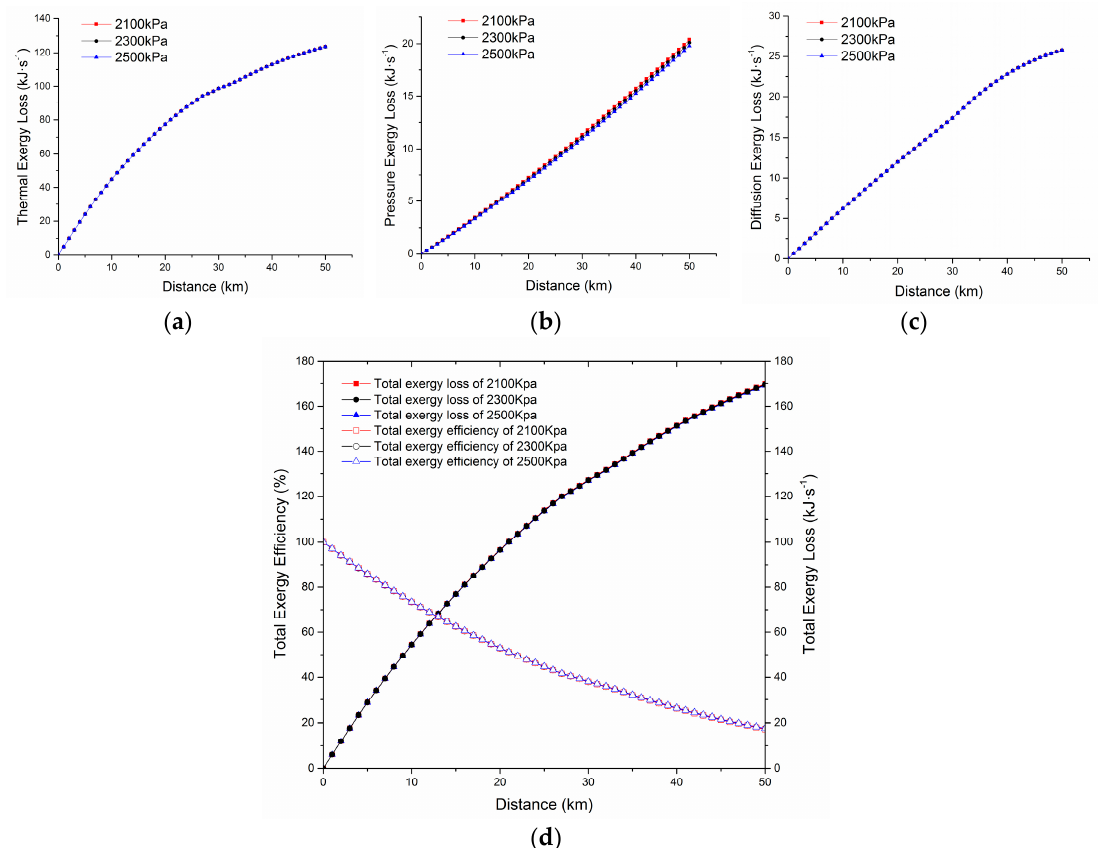
Figure 5. ( a ) The axial distribution of thermal exergy loss under different out-station pressures; ( b ) The axial distribution of pressure exergy loss under different out-station pressures; ( c ) The axial distribution of diffusion exergy loss under different out-station pressures; ( d ) The axial distribution of total exergy loss/efficiency under different out-station pressures.